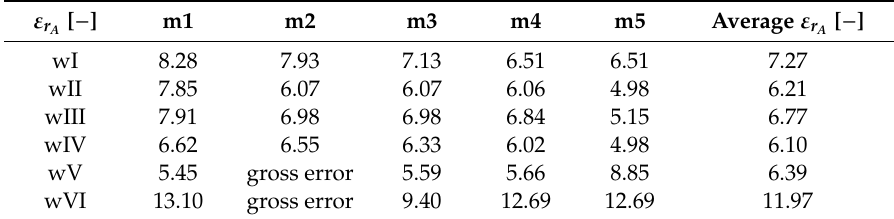
Table 7. Dielectric constants calculated based on the amplitudes (“A”